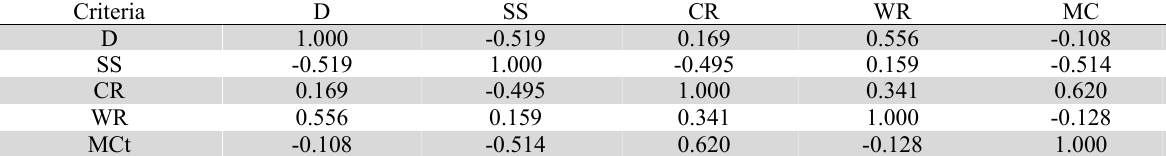
Correlation coefficient values for Example 3 Criteria